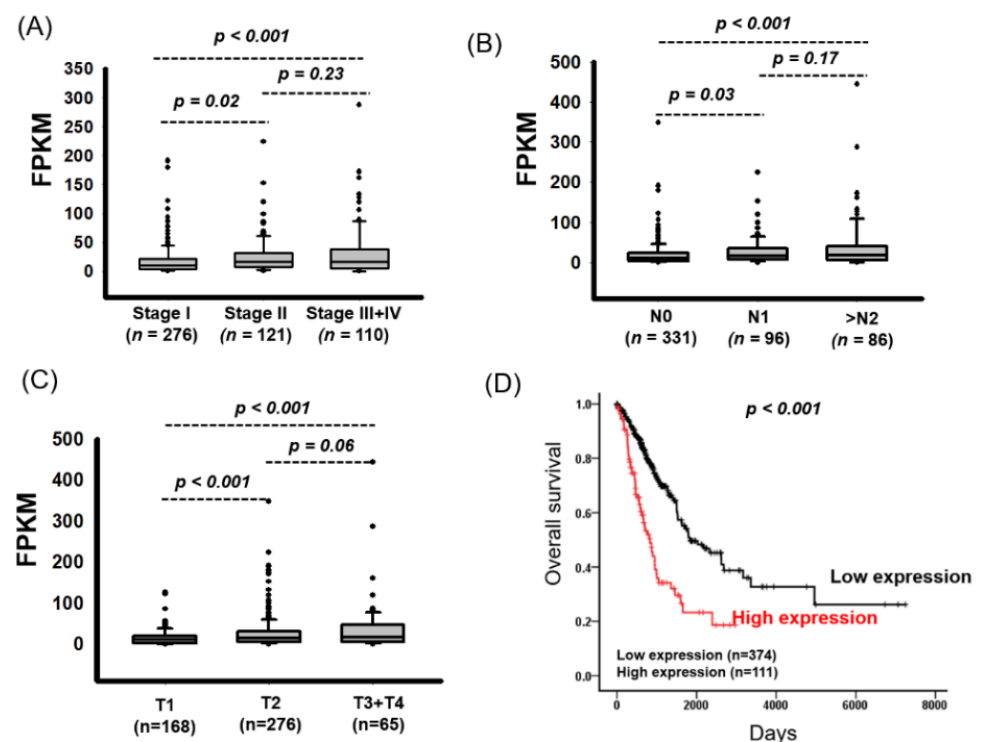
Figure 2. Association of FAM83A Expression with Poor LUAD Prognosis. ( A ) FAM83A expression in LUAD by pathological stage. ( B ) FAM83A expression in LUAD by lymph node metastasis status. ( C ) FAM83A expression in LUAD by T stage. ( D ) Kaplan-Meier survival curves showing the effect of FAM83A expression on overall survival in LUAD.